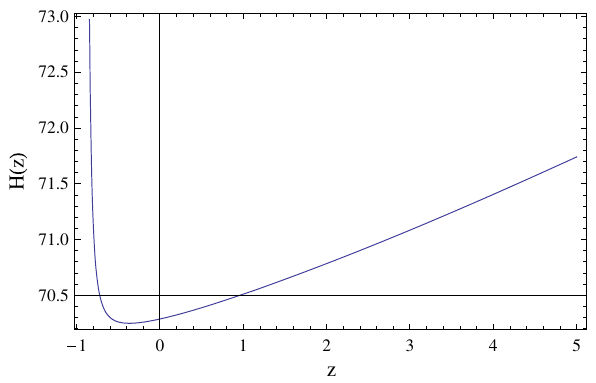
Fig. 10 Variation of H ( z ) with the variation of z (Model II) by con- sidering the best fit values w 0 = − 0 . 797 ,w 1 = 0 . 499